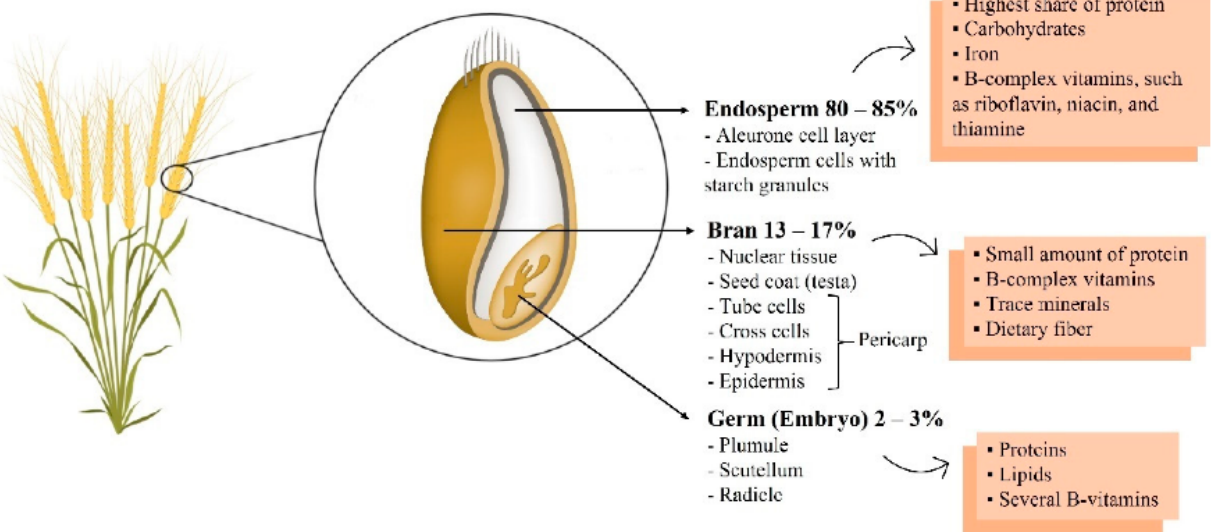
Figure 1. Whole grain wheat composition. Reproduced with permission from Sabença et al., Wheat/gluten-related disorders and gluten-free diet misconceptions: A review; published by Foods , 2021 [11].